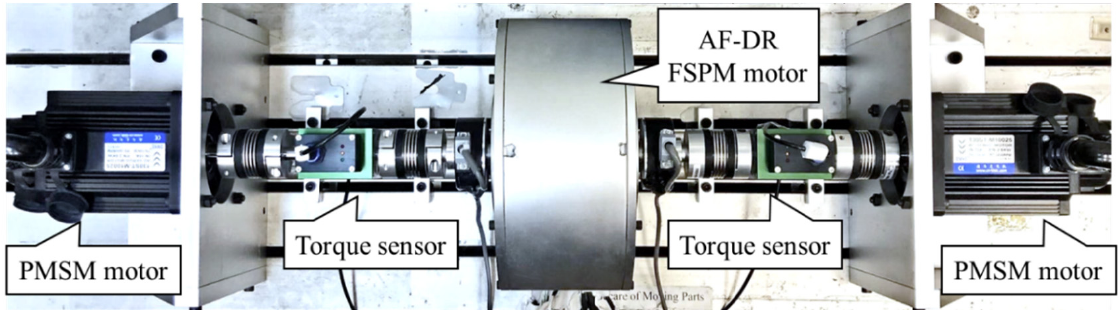
Figure 9. Experiment setup of the testbed. Table 3. Design parameters of the prototype.